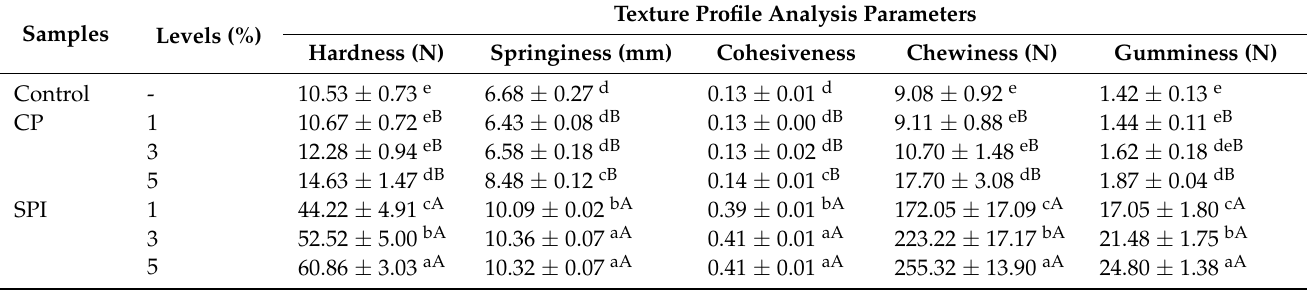
Table 1. Effects of the addition of cricket powder (CP) and soy protein isolate (SPI) on the texture profile analysis (TPA) parameters of mackerel surimi